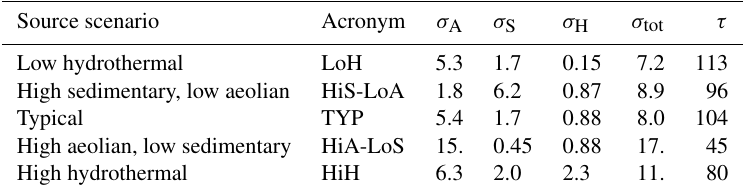
Table 1. Iron source strengths in units of GmolFeyr − 1 for the typical state and four other states sampling our family of solutions. Source strengths are listed for aeolian ( σ A ), sedimentary ( σ S ), hydrothermal ( σ H ), and total ( σ tot ) iron. The corresponding bulk iron lifetime, τ , in units of years, is also tabulated ( τ is the ratio of the global DFe inventory to σ tot ). Source